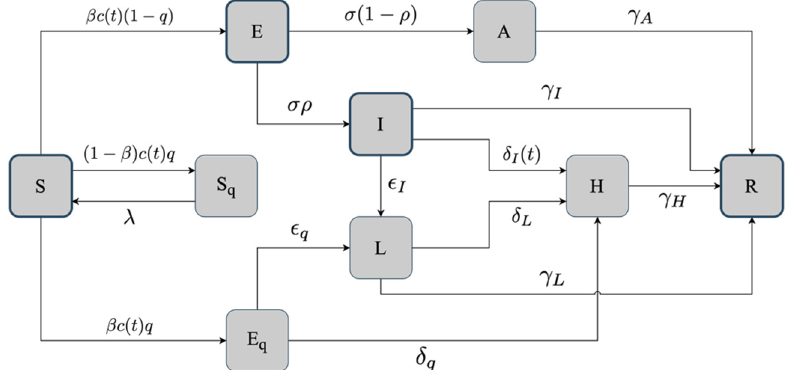
Figure 1. The BSM architecture to forecast the hospitalizations trend in Lombardy (Italy). According to BSM, the population is divided into nine compartments: susceptible ( S ), exposed ( E ), infected ( I ), recovered ( R ), quarantined susceptible ( S q ), asymptomatic ( A ), hospitalized ( H ), quarantined exposed ( E q ), isolated infected ( L ). Interactions among compartments are depicted as directed segments, also reporting the related transition rates.